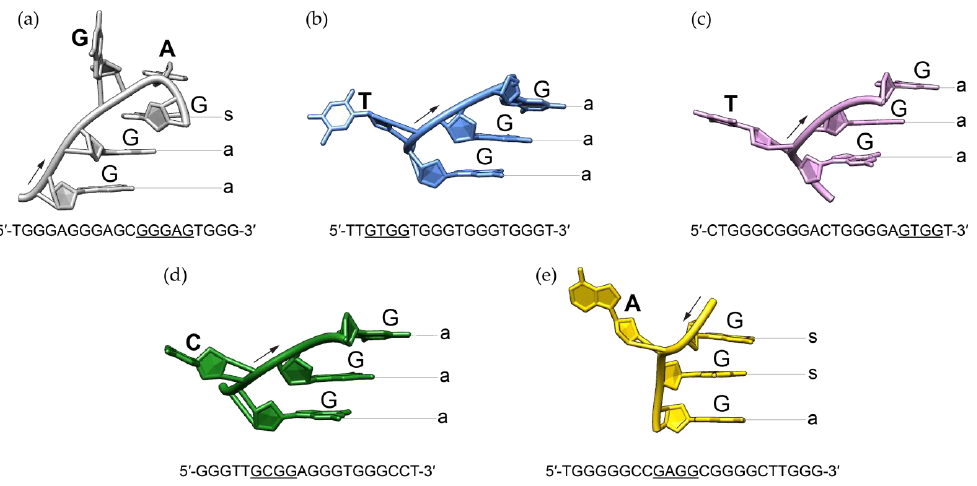
Figure 5. Comparison of bulge-containing G-strand progression between ( a ) RAN1* (this work, PDB ID 6ZRM), ( b ) TB-1 (PDB ID 2M4P) [27], ( c ) LTR-IV (PDB ID 2N4Y) [28], ( d ) hTR 1-20 (PDB ID 5UA3) [29] and ( e ) TP3 (PDB ID 6AC7) [30]. G-tract that includes a bulge and whose structure is